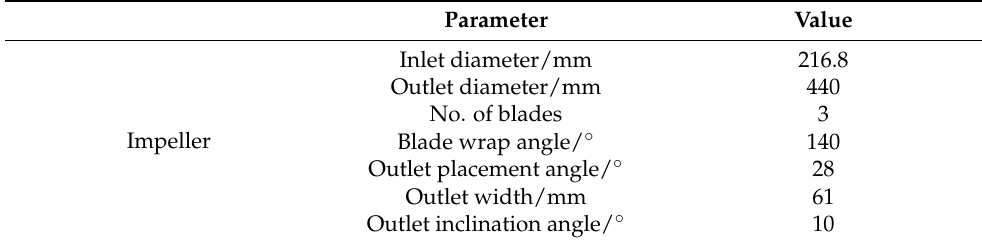
Figure 1. Structure model diagram of mining pump. The mining pump impeller design has the geometric parameters shown in Table 1. Table 1. Geometric parameters of model pump impeller.